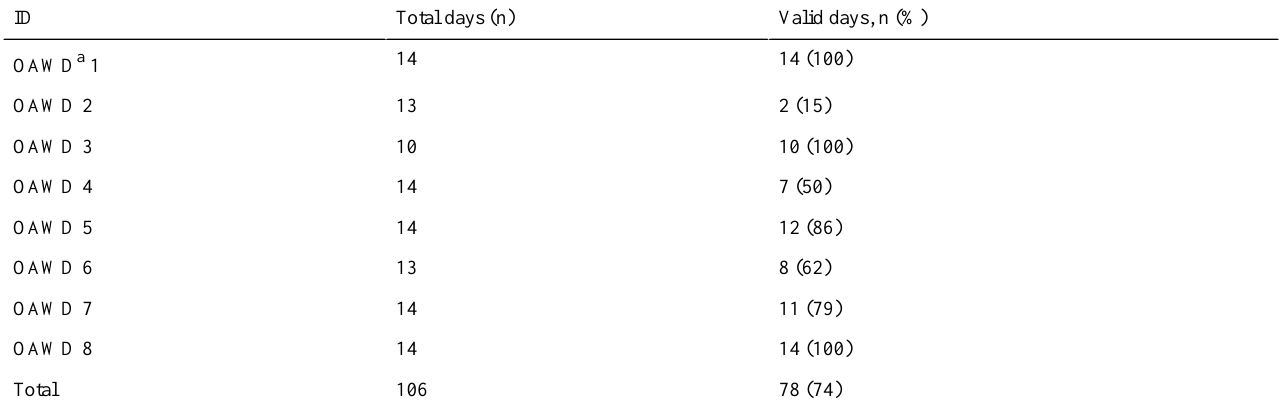
Table 4. Number of days with sleep reported by the Mi Band 2 for older adults living with